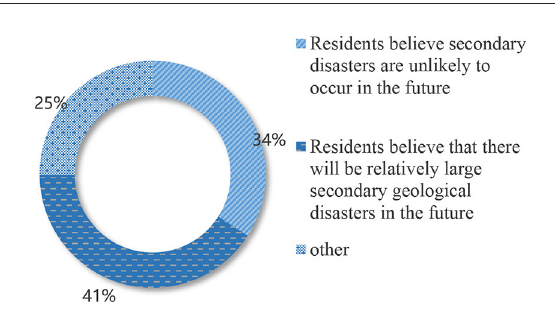
FIGURE4 Residents’ views on secondary geological disasters in the